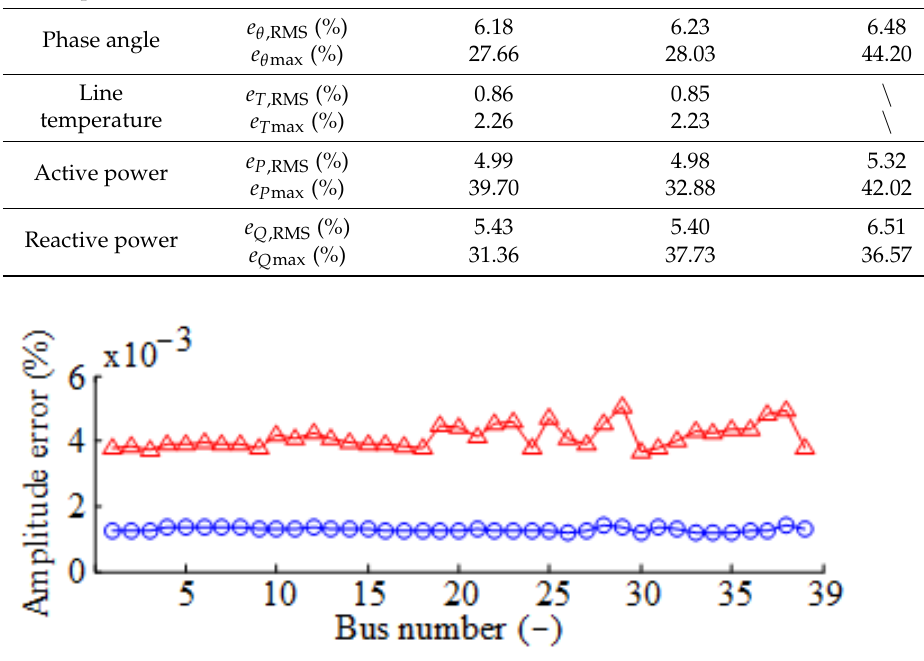
Table 2. Estimated errors with different methods.